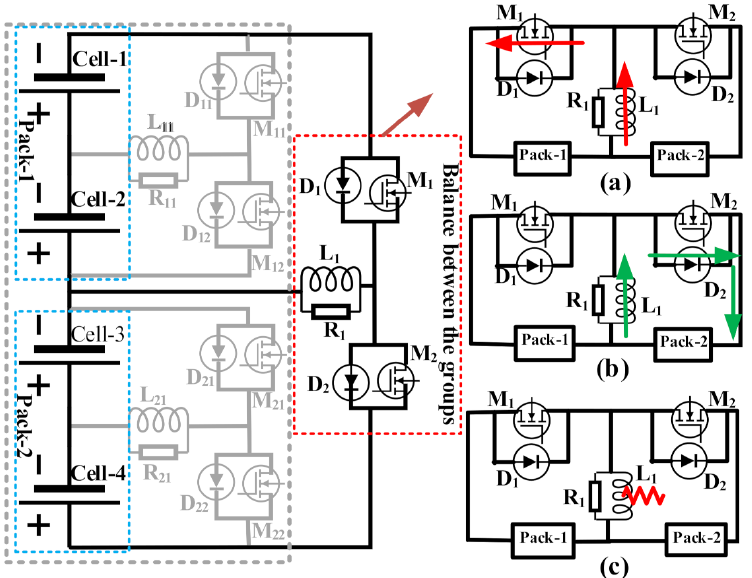
Figure 4. Schematic diagram of the balance process between groups. ( a ) Pack-1 discharging, ( b ) Pack- 2 charging, ( c ) L 1